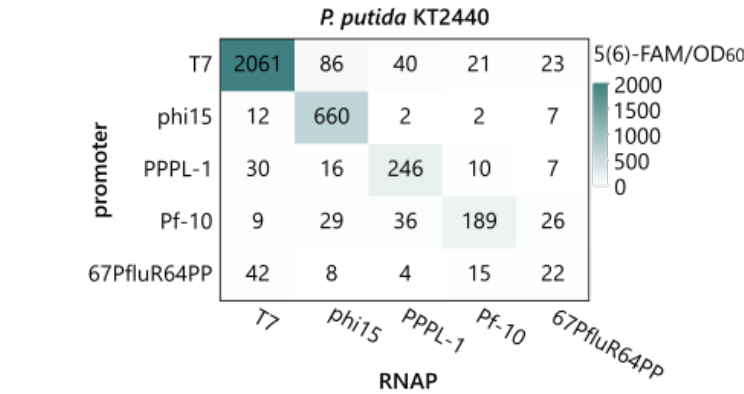
Figure 4. To verify cross-recognition between the phage RNAPs and their promoters, all 25 combinations of RNAPs and phage promoter-msfGFP reporter constructs were introduced in P. putida KT2440 and induced with 0.3 mM 3mBz overnight. The fluorescent intensity was normalized for the OD and expressed as an equivalent 5(6)-FAM concentration (nM). Values represent the mean normalized fluorescence intensity after overnight induction of four biological replicates. The statistical analysis of all pairwise comparisons and a connecting letter report are provided in Tables S4 and S5.